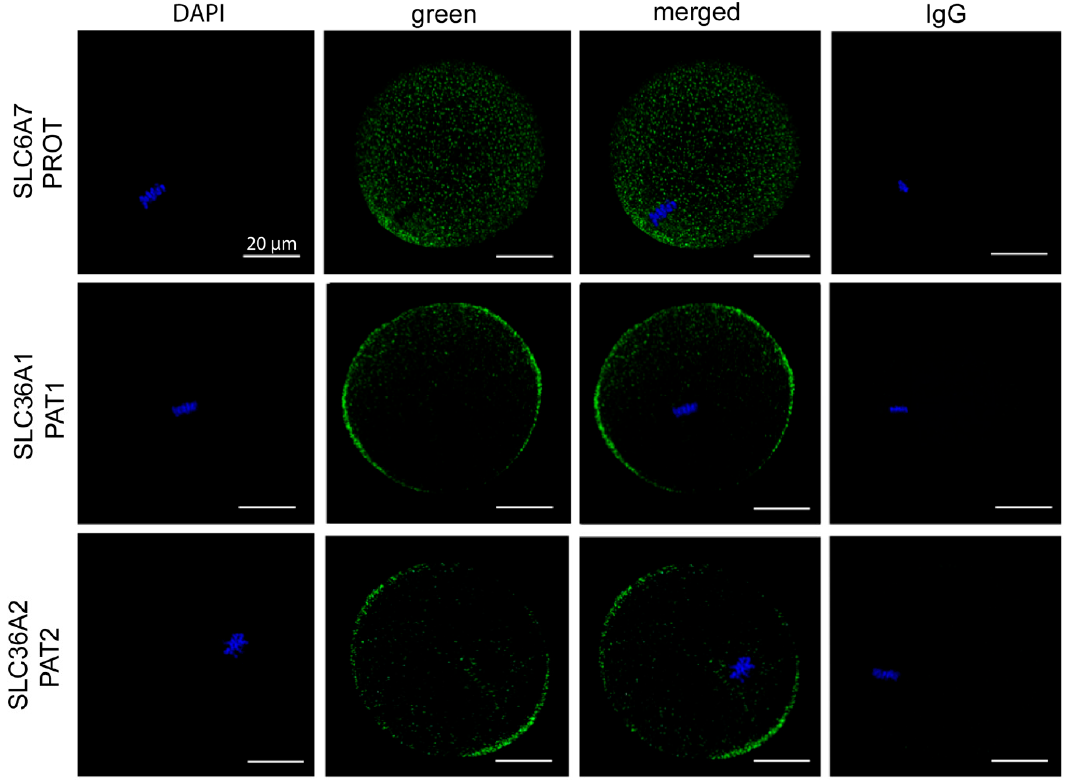
Figure 3. Expression of Pro transporters PROT, PAT1, and PAT2 in mouse oocytes. Oocytes were freshly isolated at 13–15 h post-hCG and exposed to Pro (0.4 mM) for 100 min, fixed, and immunostained for SLC6A7 (PROT), SLC36A1 (PAT1), and SLC36A2 (PAT2) (green). Metaphase chromosomes were counterstained with DAPI. Oocytes were analysed by confocal microscopy using a 40× objective. Images are representative of 6 oocytes taken from 3 independent experiments. A pre-immune IgG equivalent was used as a negative control for the primary antibody. Scale bar = 20 µm for all images.